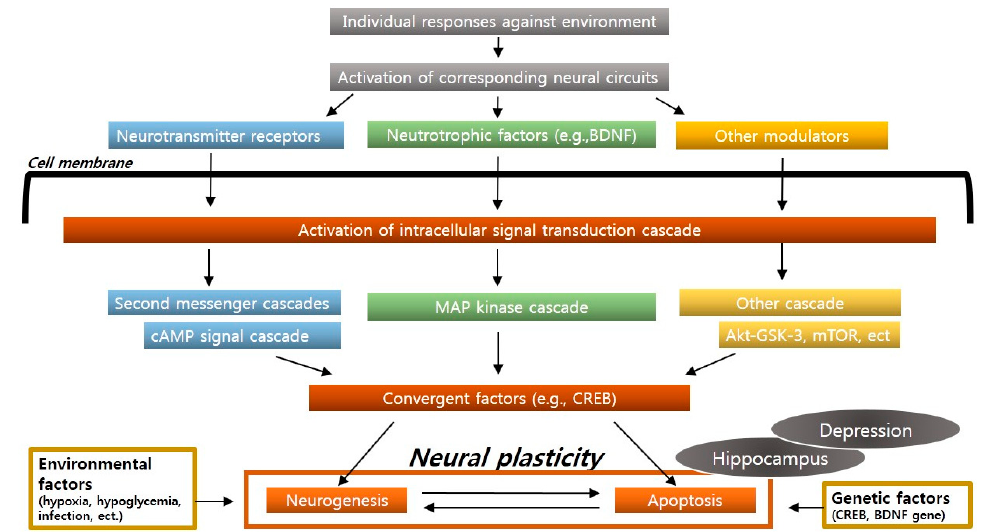
Figure 1. The concept of an intracellular signal transduction cascade and neural plasticity.